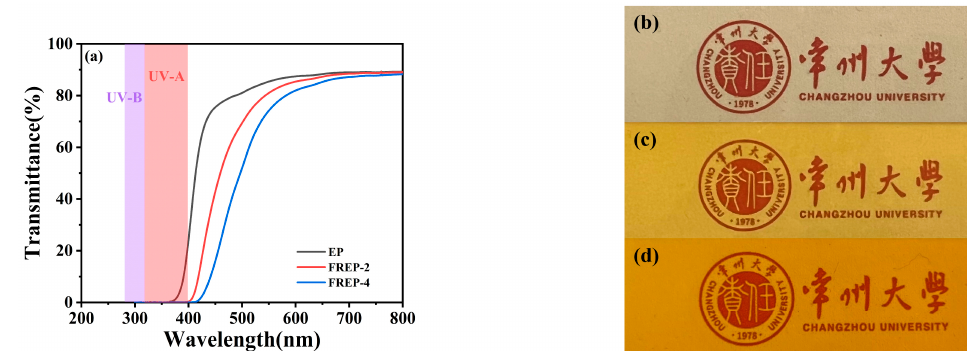
Figure 6. ( a ) Transmittance spectra of the pure EP and the FREPs in the range of 200–800 nm; optical images of the pure EP ( b ), FREP-2 ( c ), and FREP-4 ( d ).